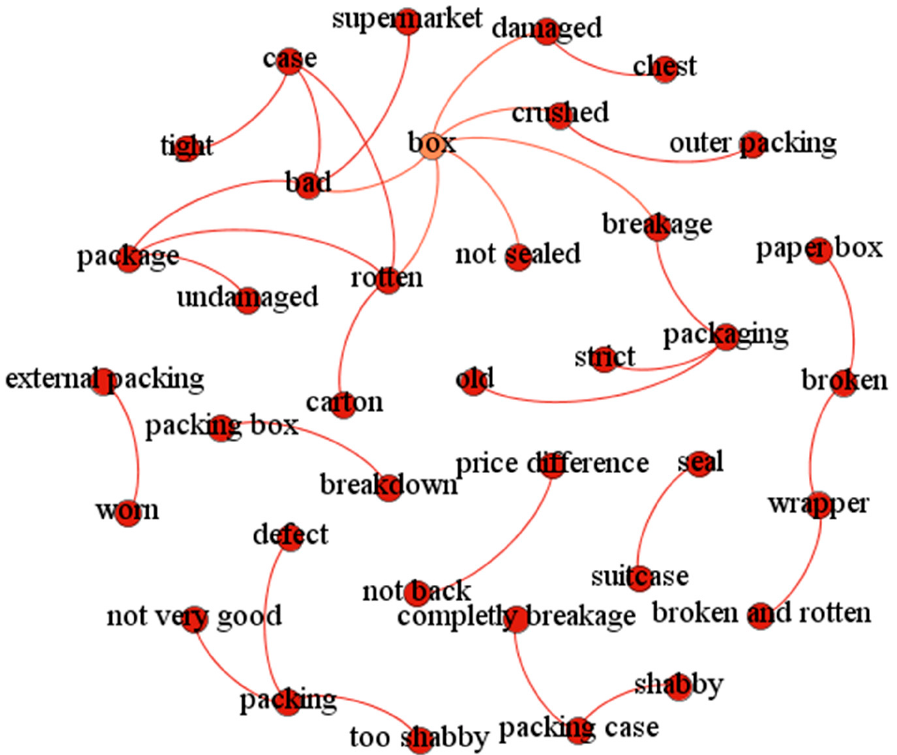
Figure 11. The association network under the negative emotion of the topic ‘Package’. Table 4. Top 15 word pairs with probability of positive emotion of topic ‘Crowd’ and negative emotion of topic ‘ Package ’.